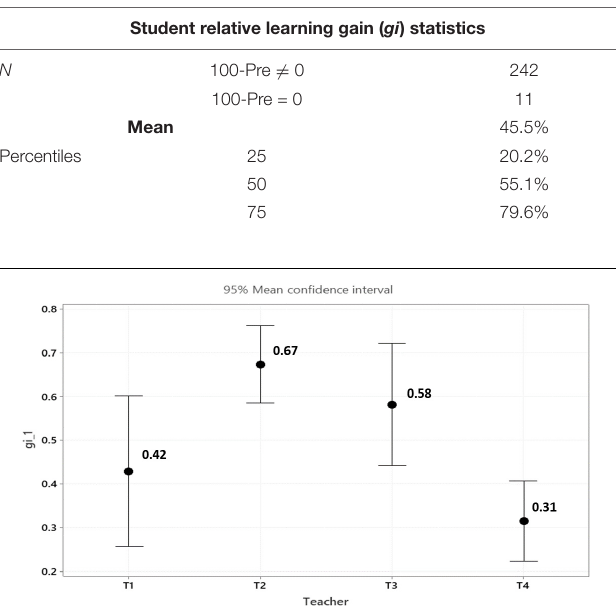
TABLE 3 | Students relative learning gain ( gi ) statistics for the first activity.